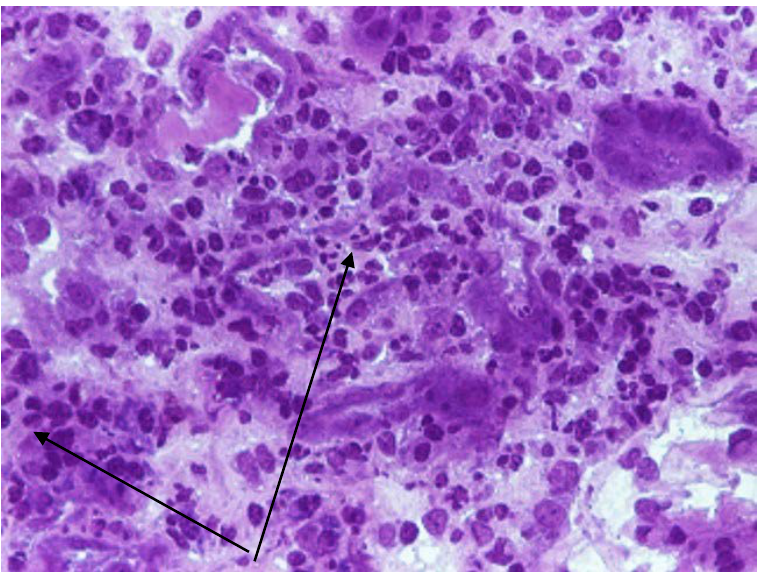
Figure 2. Kidney biopsy—Interstitial Nephritis. Toluidine Blue coloration in optic microscopy (×200) showing infiltrates with polymorphonuclear cells in the renal interstitium and tubules—black arrows).